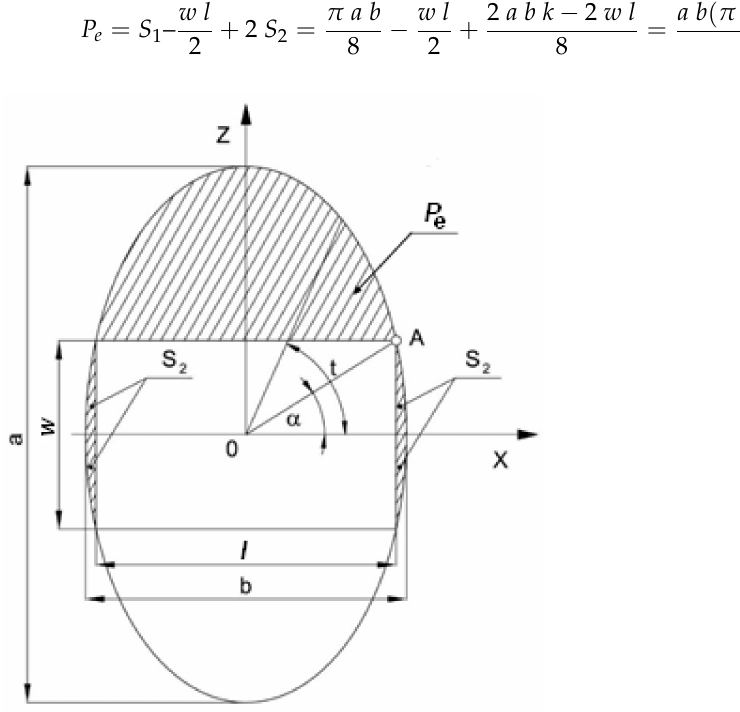
Figure 2. The relaxed zone around the void (excavation) in the rock mass